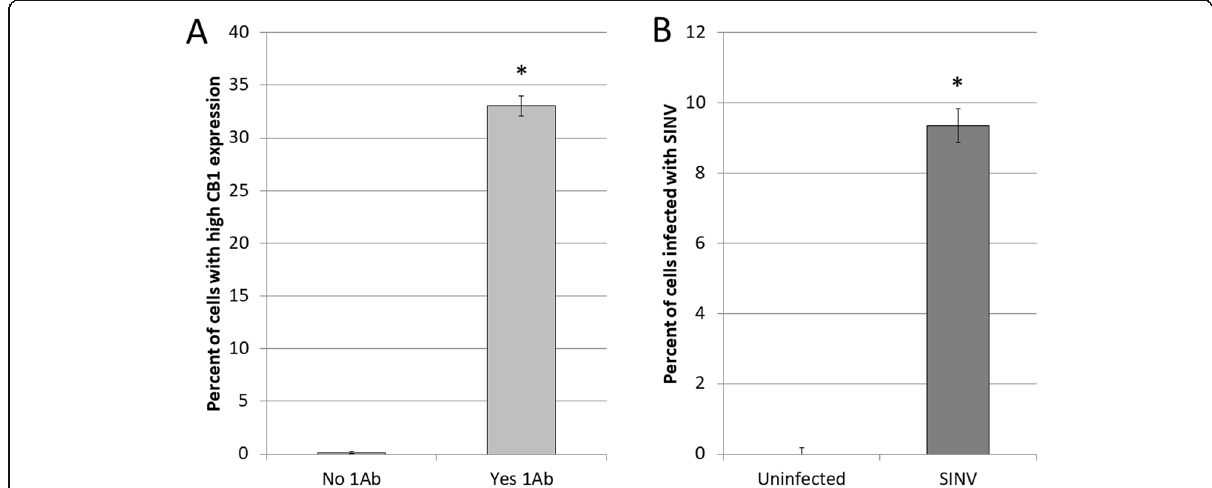
Fig. 1 a Validation CB1 receptor expression in human liver (Huh7) cell line. Cells were exposed to a primary antibody (1Ab) that binds specifically to the cannabinoid receptor I (ab23703). The antibody is conjugated with a fluorophore for detection and quantification. Cells with no 1Ab, did not give off any signal, whereas cells exposed to the primary antibody-targeting CB1 resulted in high level of detection, indicating a strong presence of the CB1 receptor. b Human liver (Huh7) cells can successfully be infected with Sindbis virus. After 24 h, nearly 10% of cells are infected with Sindbis